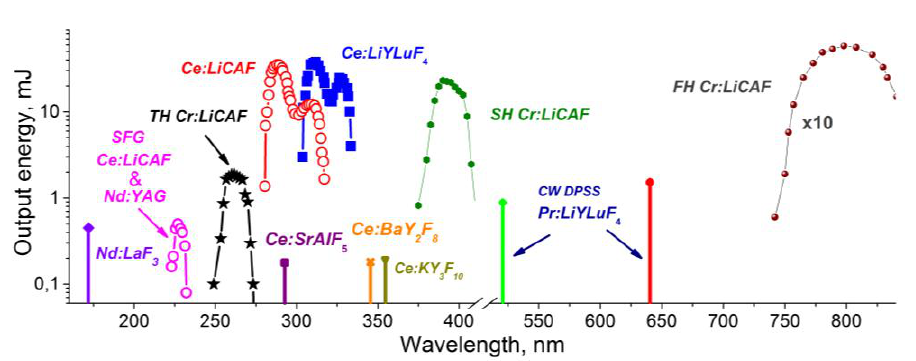
Fig. 1. Summary properties of solid-state lasers based on fluoride crystals with the structure of scheelite (LiY 1-x Lu x F 4 ) and colquiriite (LiCa 1-x Sr x AlF 6 ), implemented at Kazan Federal